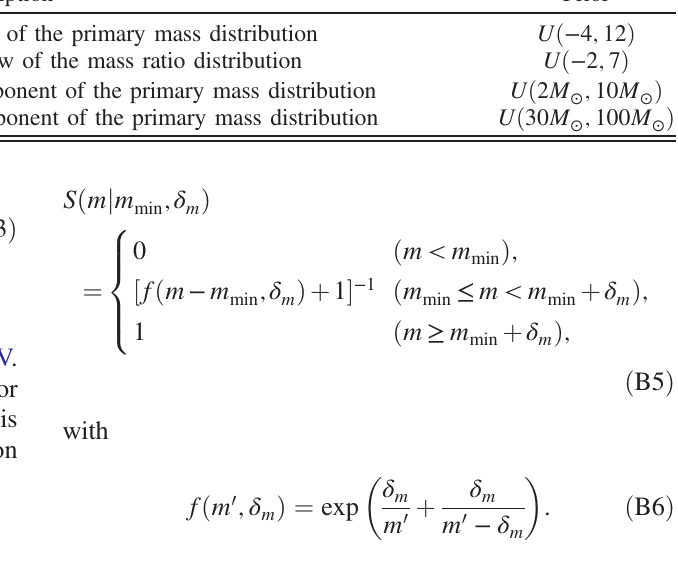
TABLE V. Summary of T RUNCATED model parameters. Parameter Description